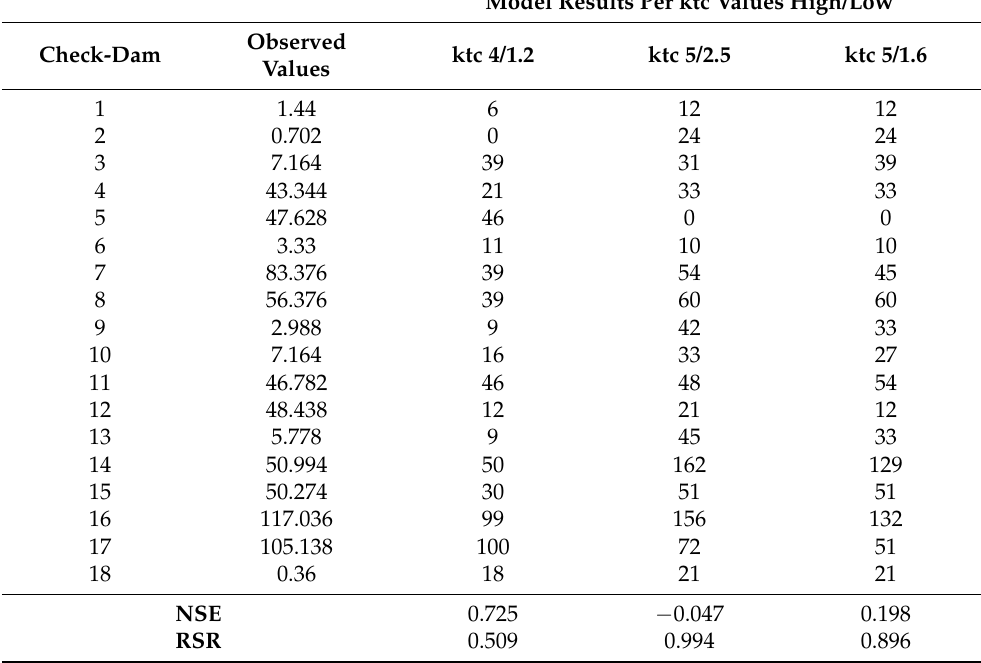
Table 5. The ktc ratios used to calibrate the WaTEM/SEDEM. Ktc 4/1.2 corresponds to 1;3.33 ratio, ktc 5/2.5 corresponds to 1:3.80 ratio and 5/1.6 corresponds to 1:2.20 ratio. Model Results Per ktc Values High/Low Observed ktc 4/1.2 ktc Check-Dam Values